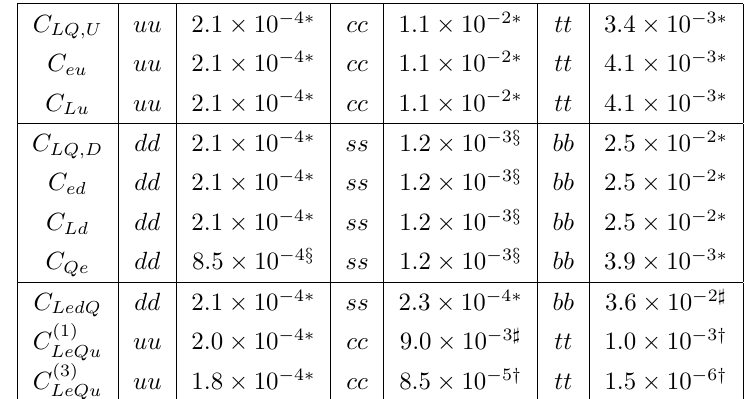
Table 12 . 90% C.L. upper limits on the quark-flavor-conserving semileptonic operators, assuming a single operator is turned on at the scale Λ = 1 TeV. The superscripts represent that the strongest limit is imposed by decay modes ( ∗ ) τ → eπ + π − , ( † ) τ → eγ , ( § ) τ → eη and ( ] ) τ → eη 0 . For the scalar and tensor operators, the bounds apply to both the τe and eτ